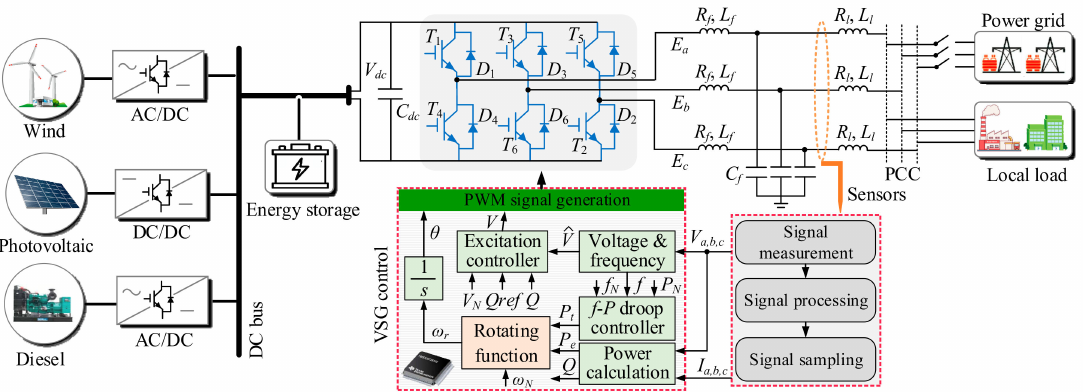
Figure 1. VSG control strategy for microgrid.